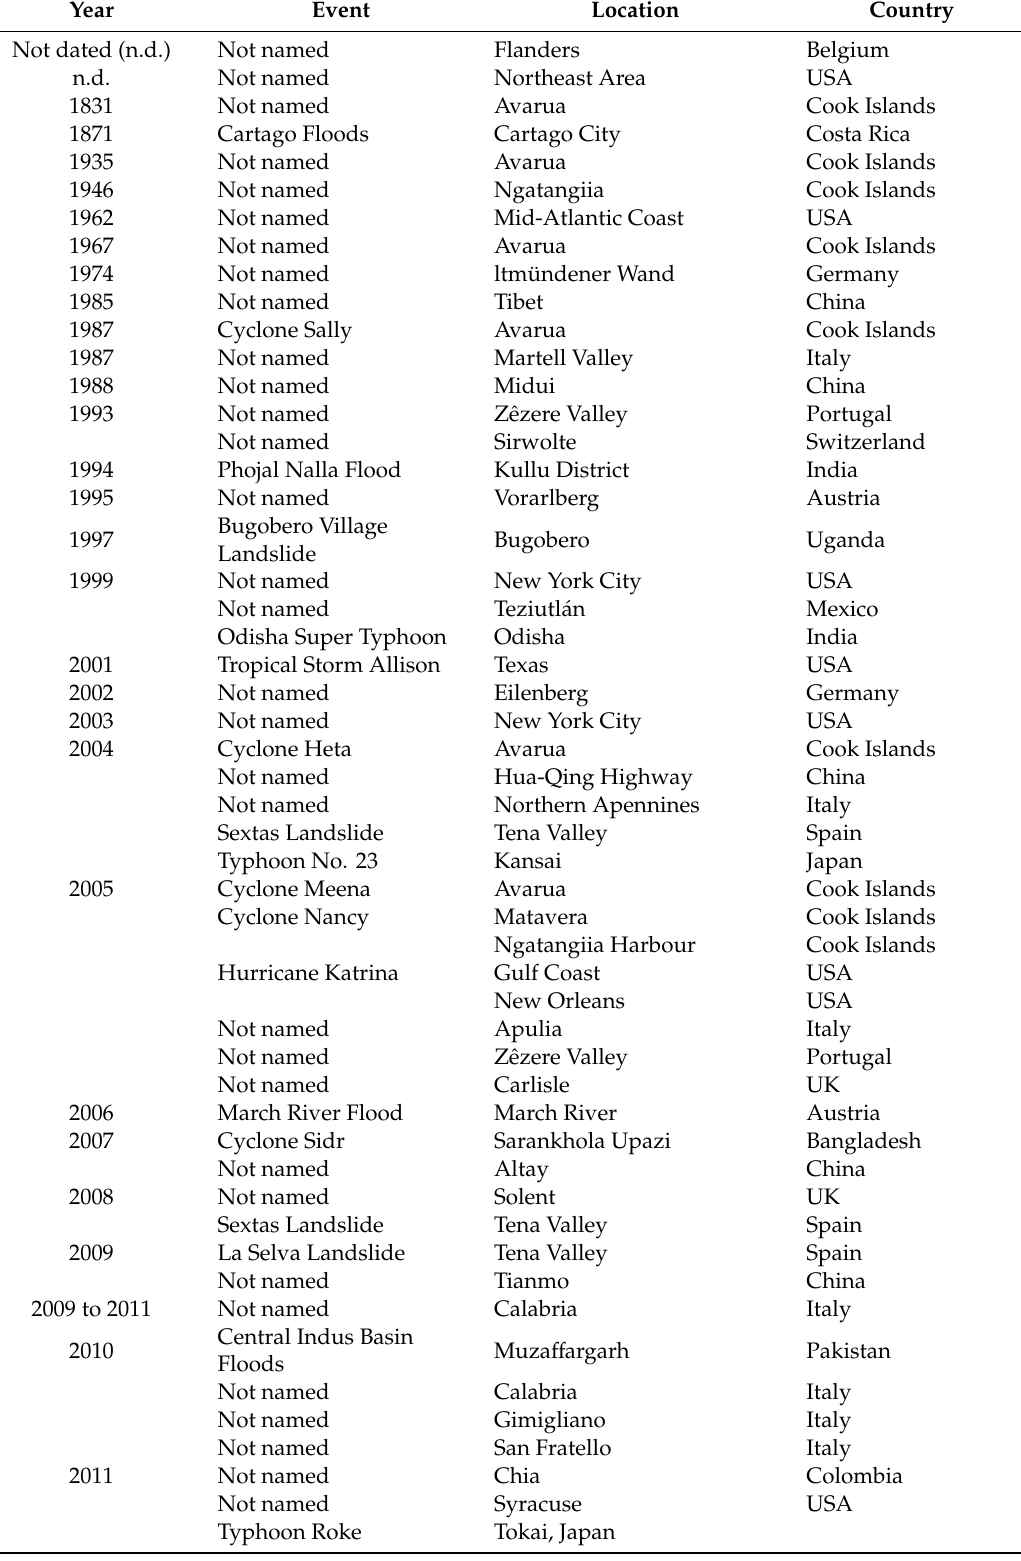
Table 2. Events and Locations Addressed by Eligible Case